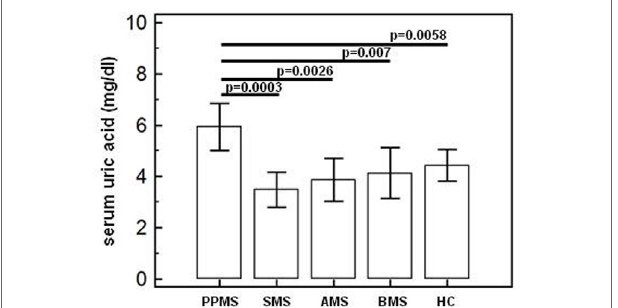
FigUre 1 | Serum uric acid concentration. Uric acid concentration (means; mg/ dl) in serum of primary progressive (PP, n = 11), acute relapsing-remitting (A, n = 10), stable relapsing-remitting (S, n = 10), or benign (B, n = 10) multiple sclerosis (MS) patients and healthy controls (HC, n = 10). SDs are indicated by vertical bars. Statistical significance is